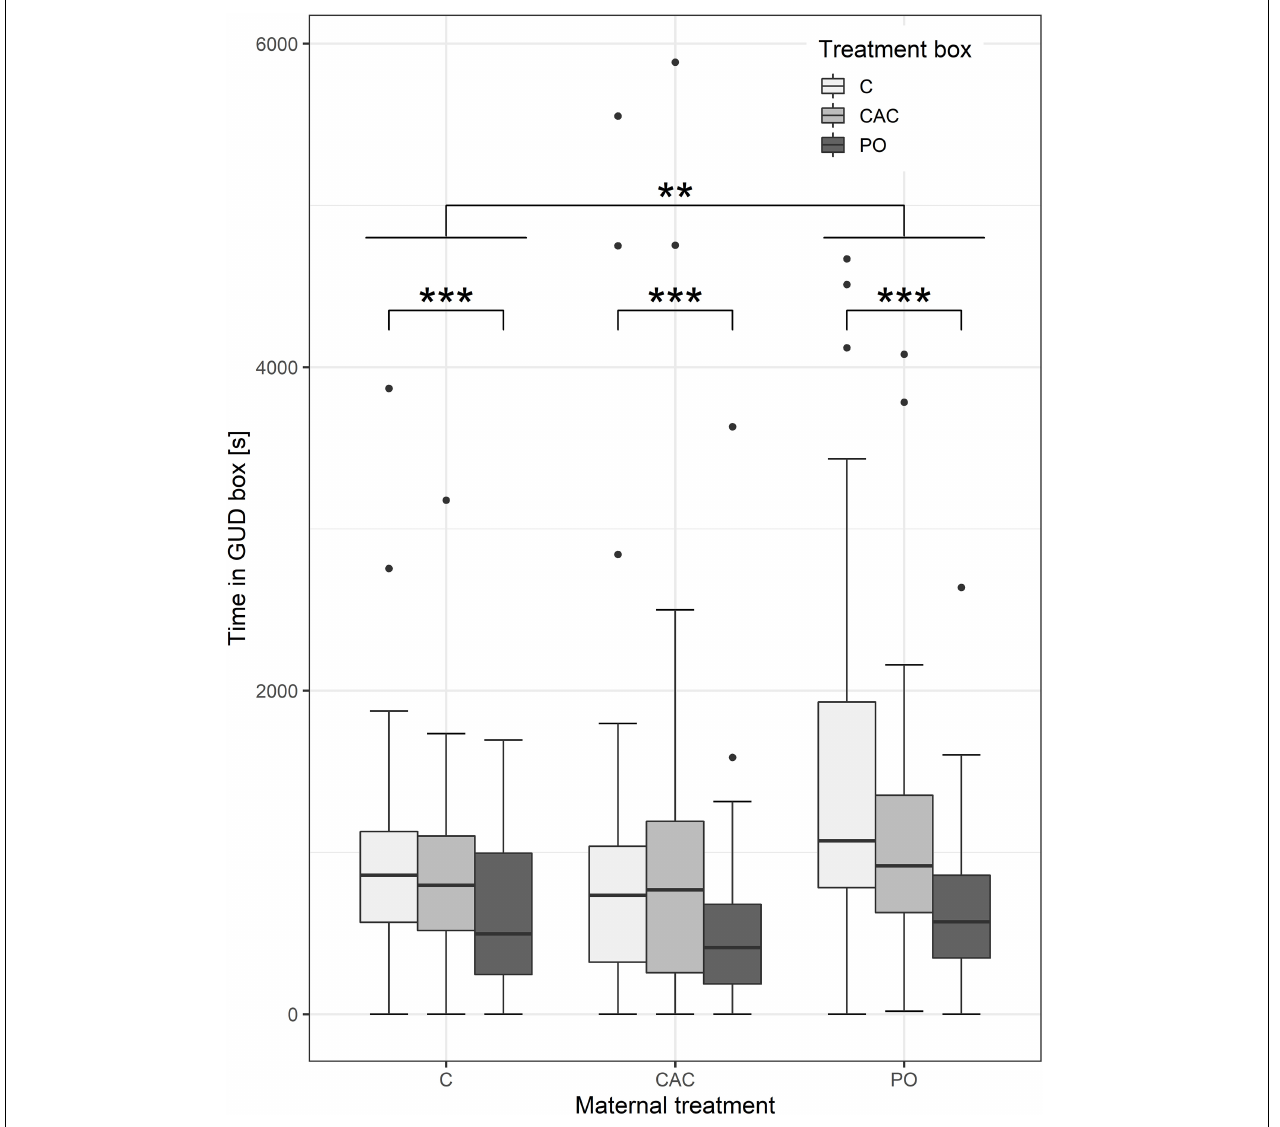
FIGURE 3 | Time spent in the GUD trays, split by maternal treatments. Asterisks indicate a significant difference from C at p < 0.01 (**) and p < 0.001